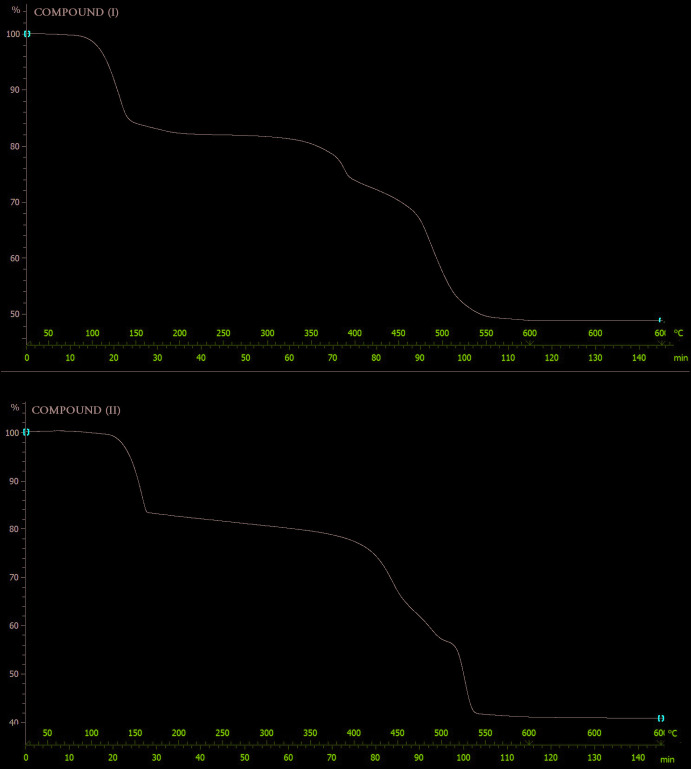
Thermogravimetric analysis of compounds (I) and (II).